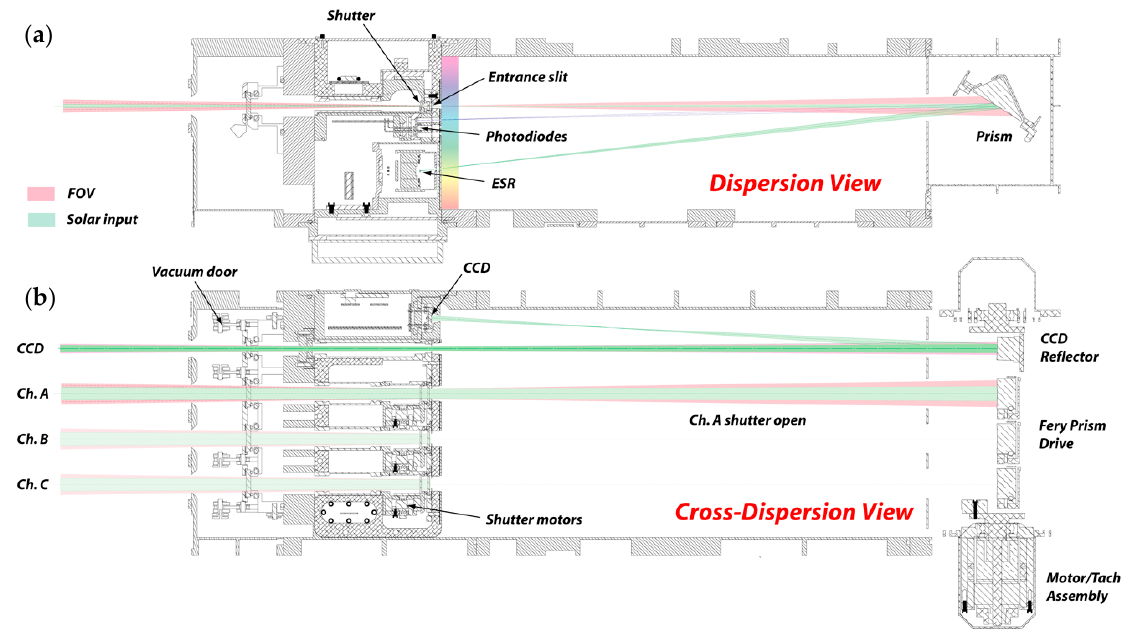
Figure 1. Overview of the Total and Spectral Solar Irradiance Sensor (TSIS-1) Spectral Irradiance Monitor (SIM). The SIM is a constant-deviation monochromator that is based on the Féry prism for spectral dispersion and image quality control. ( a ) The dispersion view, where the prism is the only optical element. Focal plane detectors include three separate photodiode detectors for rapid scan solar measurements and an Electrical Substitution Radiometer (ESR) for long-term SSI calibration maintenance. ( b ) Cross-dispersion view showing three separate, but redundant, measurement channels used for long-term degradation corrections. The CCD system is a closed loop optical encoder mechanism to actively control the prism incidence angle to ~0.5 arc-second rotational resolution.